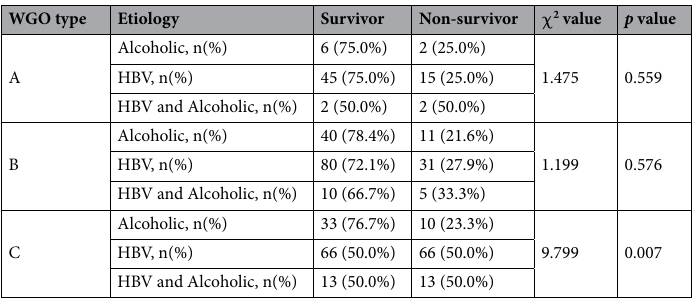
in short-term prognosis of ACLF patients ( p > 0.05). Further stratified analysis was performed according to the age, sex, etiology, WGO type, MELD score and complications, the statistical results showed that there was no significant difference in the mortality of cases in each group with or without ALSS treatment ( p > 0.05, respec- tively) (Supplementary Table S2). Development of the dynamic prediction model for prognosis of ACLF (DP‑ACLF). To determine whether the evolution of clinical indicators was related to the prognosis of ACLF, we analyzed the dynamic changes in independent prognostic factors (TB, Cr, and PTA). Temporal variation of these parameters was assessed at the third day and first, second, third, and fourth weeks after admission; Univariate Cox regression analysis was performed. We found that increases in TB and Cr and decreases in PTA at all time points were risk factors of death (Fig. 3a–c). Considering that 3–4 weeks may be an excessively long period for clinical observa- tion, we chose the third day, first week, and second week as the time nodes for calculating the changing trends of the parameters. In order to facilitate trend analysis of prognostic variables, we developed a dynamic trend score table. An increase in TB or Cr, a decrease in PTA of more than 30%, and the aggravation of HE stage were assigned 3 points; a decrease in TB or Cr, an increase in PTA of more than 30%, and the improvement of HE stage were assigned 1 point. The detailed scoring criterias were shown in Table 2. To obtain a dynamic trend score model with the best fitting degree of survival time, the variation ranges of TB, Cr, and PTA were set at 10–50%, and the variation range of HE stage was set at 1–3 levels previously. Univariate Cox regression was used to calculate the corresponding variation range when each model of parameter score reached the best: most Harrell’s C indexes were at their best when variation ranges were set at 30% for TB, Cr, and PTA, and when HE stage variated one level (Supplementary Tables S3–5). Multivariate Cox regression analysis showed that the dynamic trend scores of TB, Cr, PTA and HE were all independent prognostic factors of ACLF (Supplementary Fig. S1). To develop a new 90-day prognosis prediction model, we calculated the sum of dynamic trend scores (SDTs) of each patient, performed binary logistic regression analysis in combination with other independent prognostic factors, and obtained the optimal prediction model parameters and OR values through a forward progressive elimination process: age (1.034), WGO type (1.385), alcoholic etiology (0.511), TB (1.085), Cr (2.492), PTA (0.960), and SDTs (2.263) (Table 3). The obtained formula for DP-ACLF was as follows: DP-ACLF = 0.033 × age